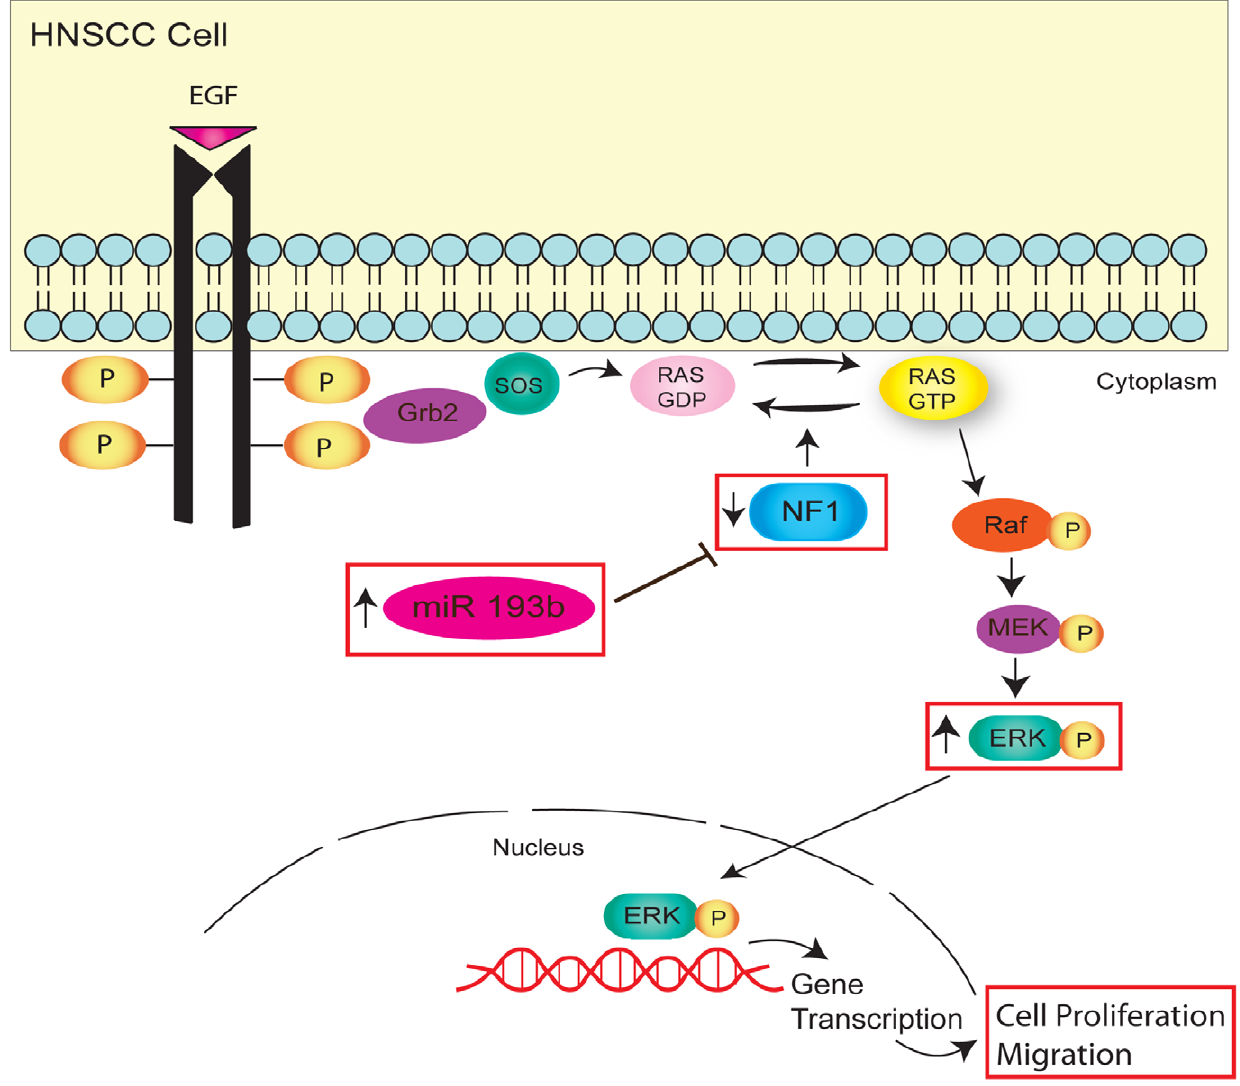
Figure 6. Proposed model for the role of miR-193b in regulating HNSCC cell proliferation and migration. Schema showing over expression of miR-193b leads to the down regulation of NF1, which prevents RAS-GTP from hydrolyzing into inactive RAS-GDP. This in turn triggers RAS signalling which leads to activation of a cascade of mitogen activated protein kinases (MAPKs), including p-ERK which can then translocate into the nucleus and promotes the expression of genes involved in cell proliferation and migration, driving HNSCC progression. Boxes indicate data demonstrated in this study.